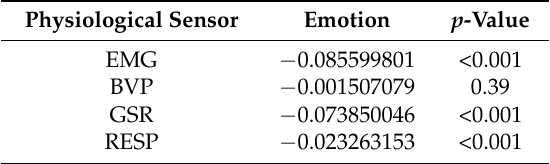
Table 9. Correlation-based ranking for physiological dataset.